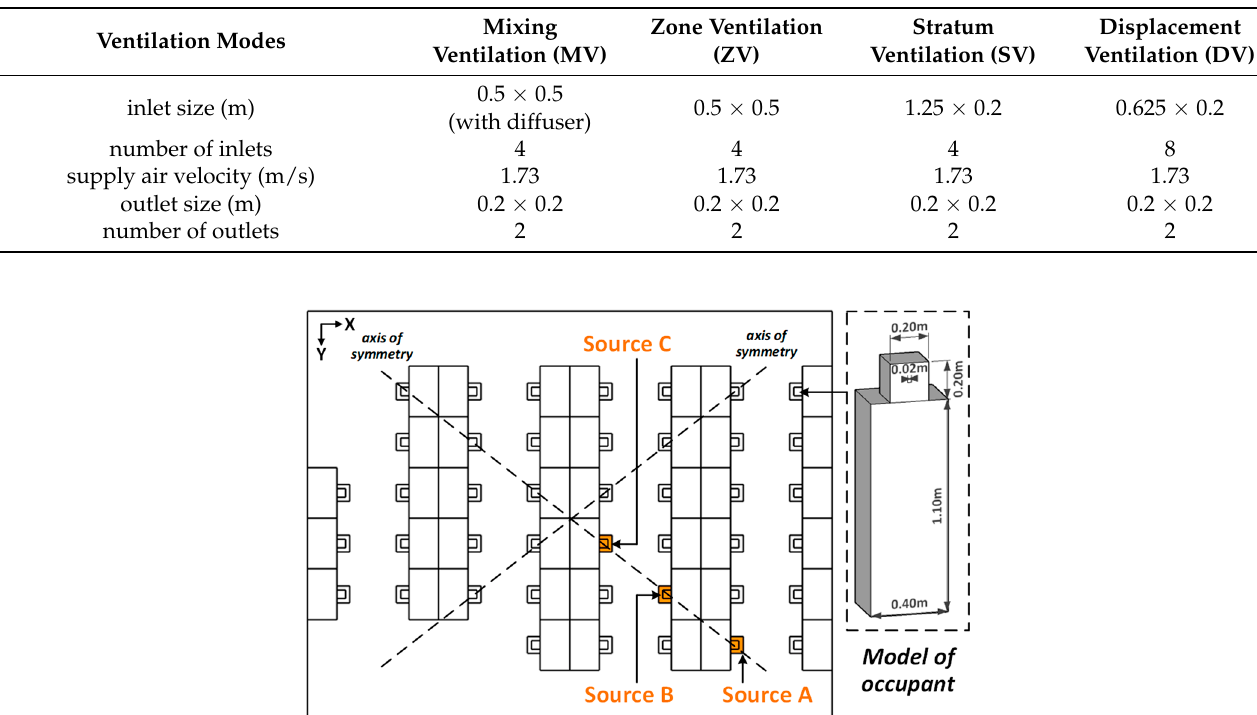
Table 1. Information of inlets and outlets for different ventilation modes.